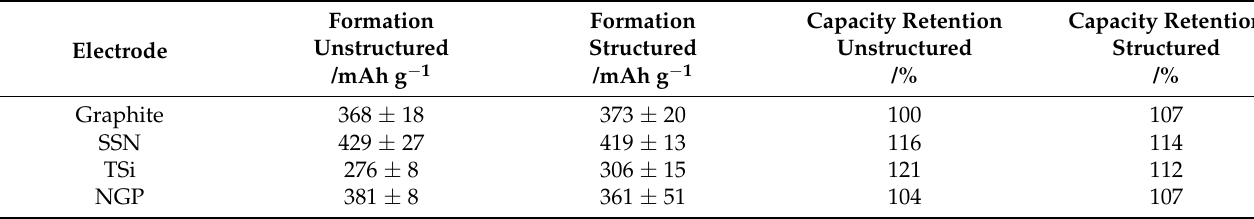
Table 6. Specific discharge capacity of the coin cells at formation and capacity retention at C/5 calculated with the first five cycles at C/5 and the last five cycles at